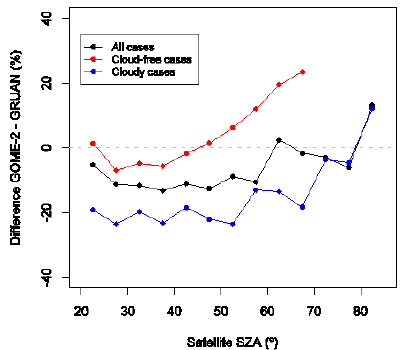
Figure 2. Differences between TWVC data retrieved by GOME- 2 and GRUAN sounding data (Eq. 3) as function of the GOME-2 ground pixel solar zenith angle (SZA) for all, cloud-free and cloudy conditions.